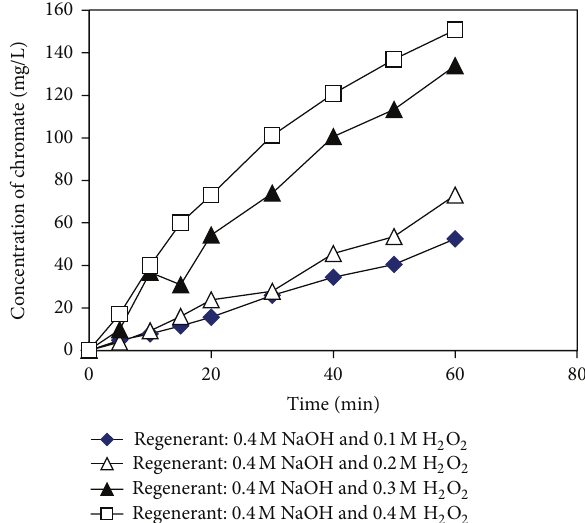
Figure 3: The regeneration efficiency depends on the amount of regenerant solutions. (The amount of exhausted resin; 2.0 g; the speed of the stirrer; 200rev./min; the volume of regenerant solution is 2.0 L) (serie